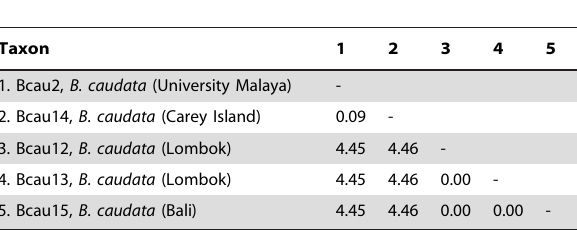
Table 2. Percentage of uncorrected ‘‘p’’ distance matrix between Bactrocera caudata samples based on combined COI and 16S rDNA